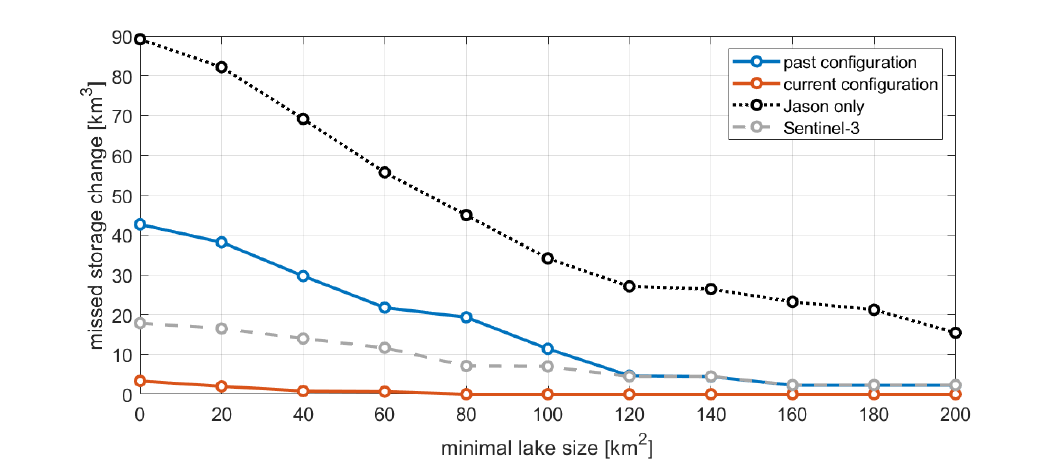
Figure 5. Missed WGHM storage changes as a function of minimal lake sizes for different altimetry